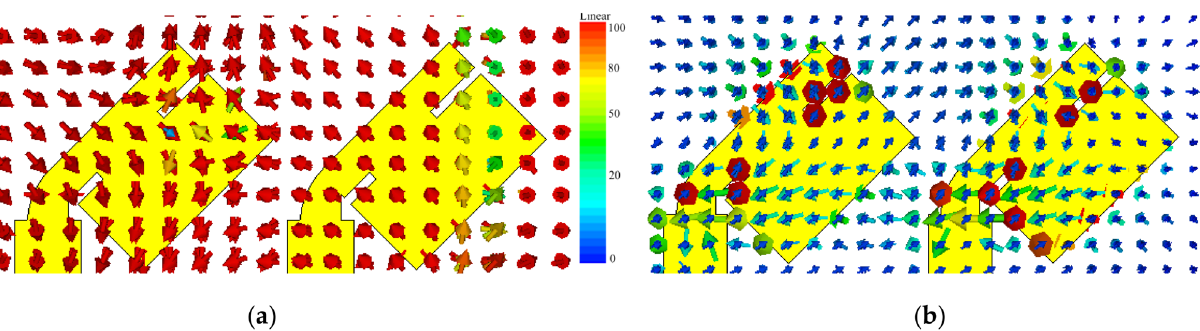
Figure 2. Surface current distribution at 29 GHz ( a ) Straight elements MIMO antenna and ( b ) proposed elements MIMO antenna.